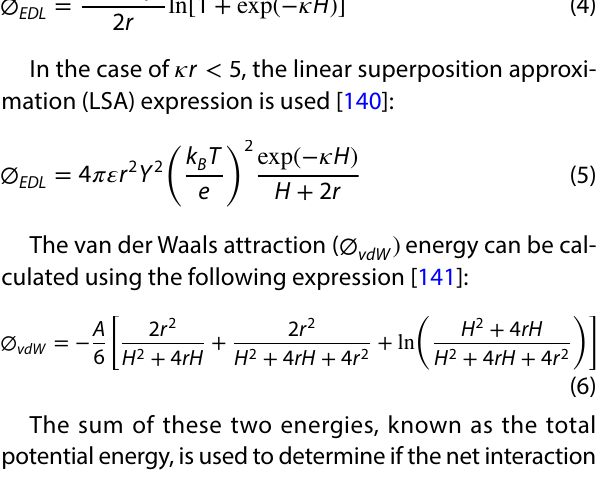
Table 1 The 42 solutions created for experimentation on the stabil- ity and aggregation of nanocrystal CdSe/ZnS QDs in aqueous sys- tems as a function of both electrolyte type and concentration and the absence and presence of SRNOM at 10 mg/L. These solutions